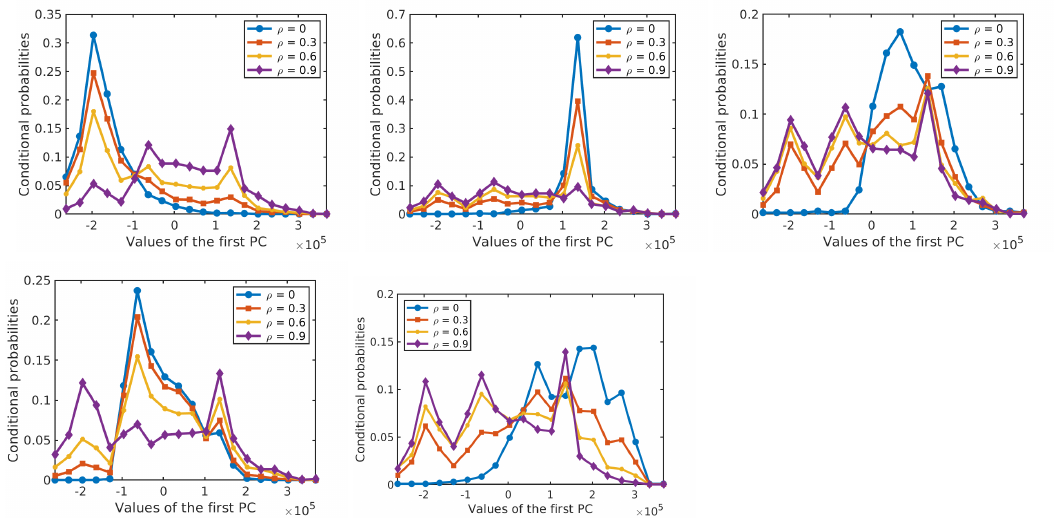
Figure 18. Conditional probabilities of the first PC for Class 1–5 (from the top left to bottom right) with different levels of label noise for the HYDICE Urban data